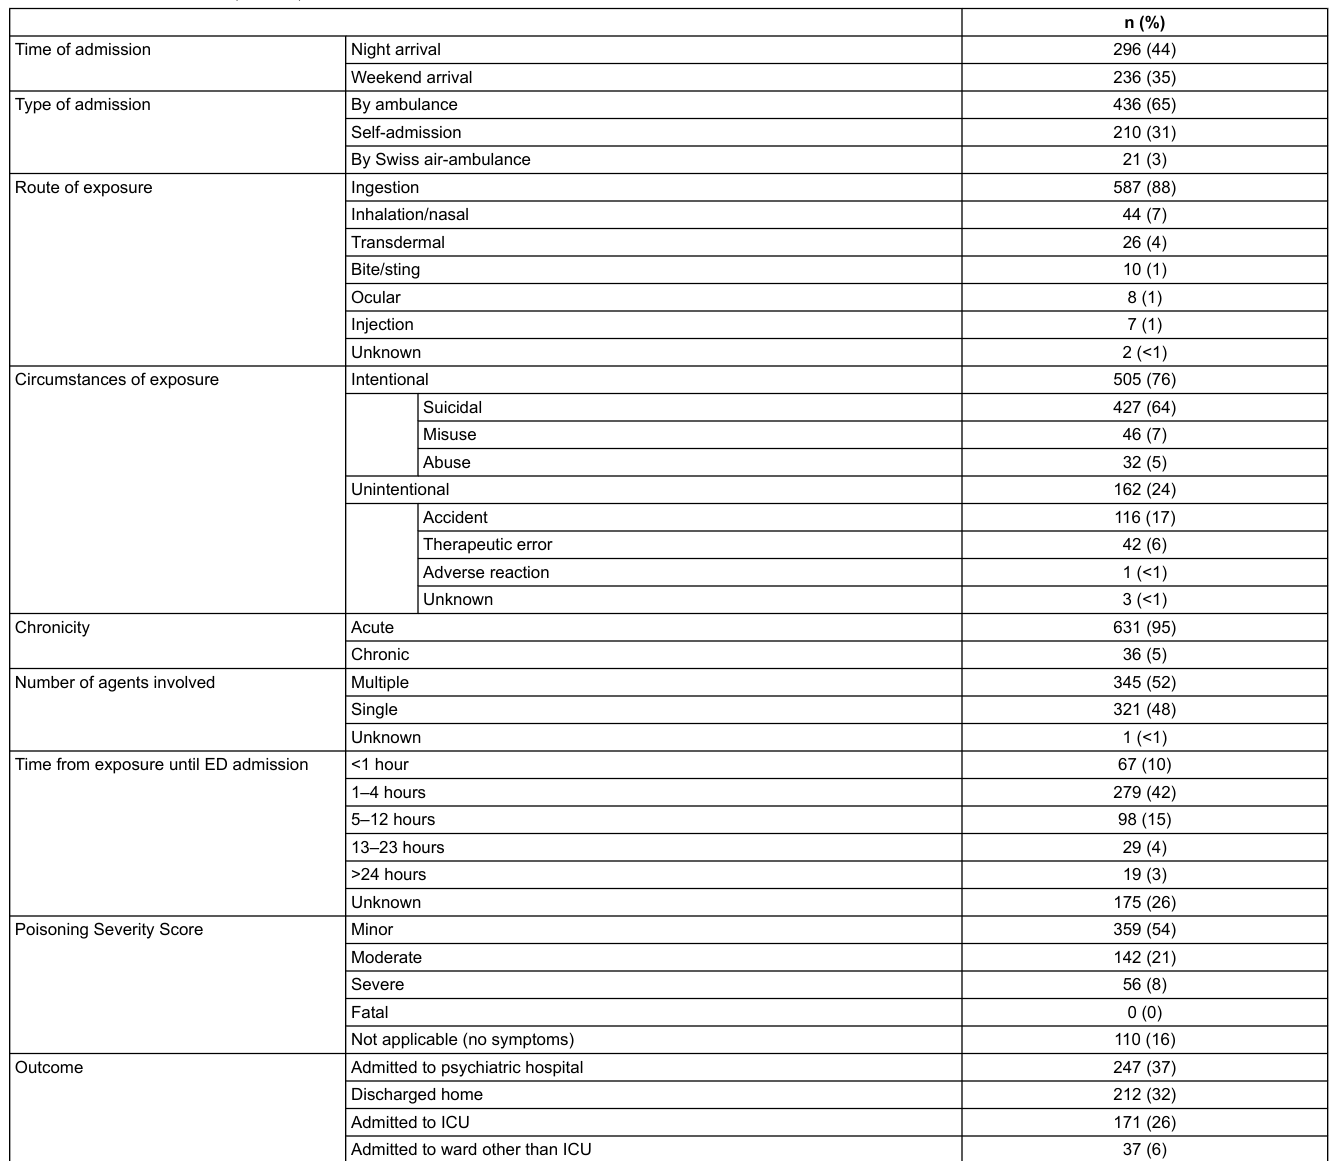
Table 1: Case characteristics (N =